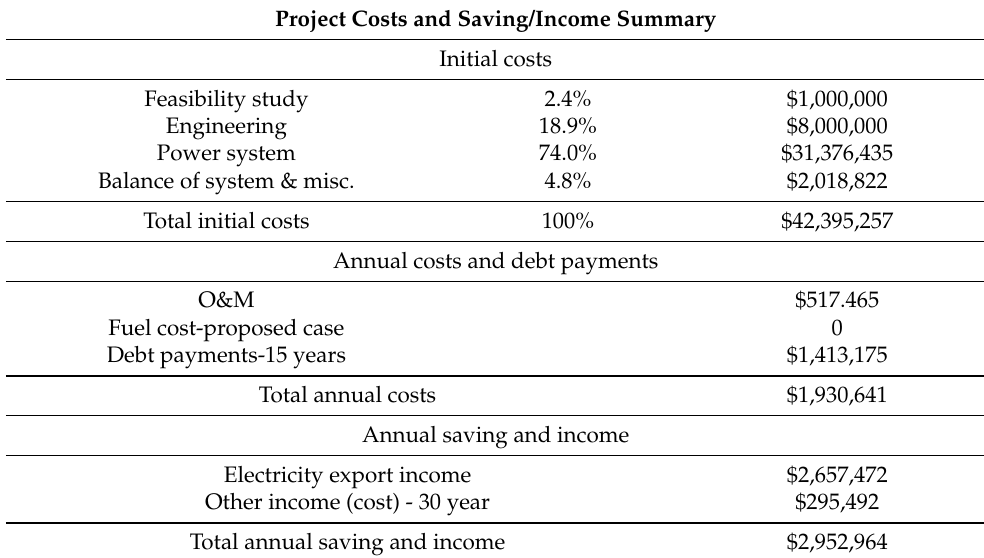
Table 7. Initial and annual costs, and annual income, for Scenario 2.